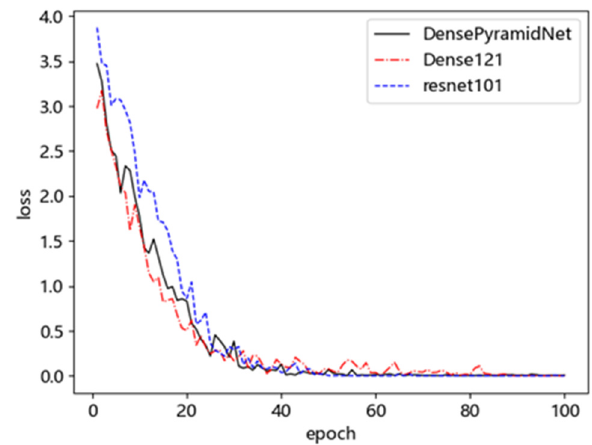
Figure 13. Training loss of three algorithms on cifar100.